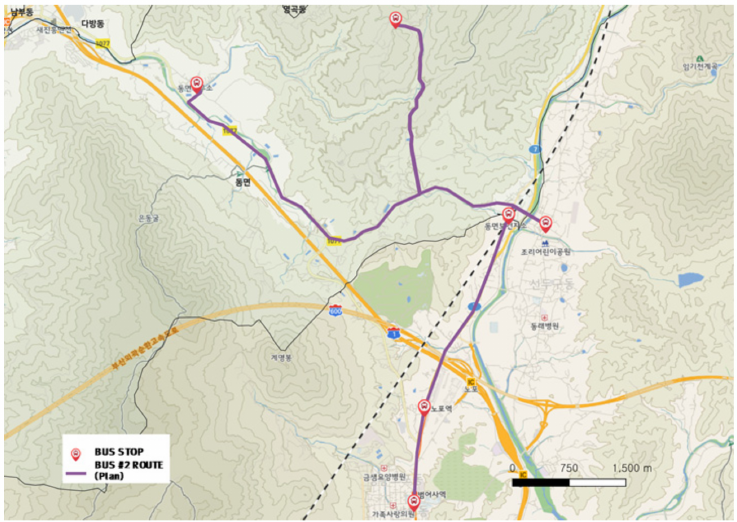
Figure 11. City-type bus No. 2